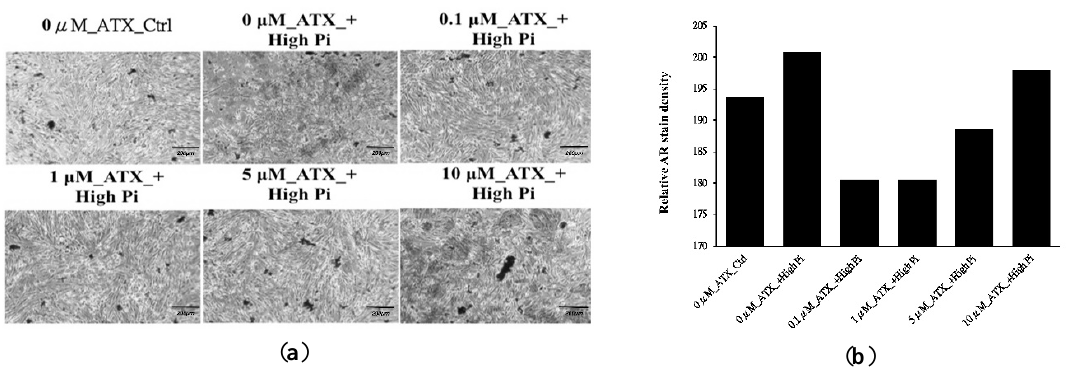
Figure 6. ( a ) Vascular smooth muscle cells were subjected to control medium (left upper) and high inorganic phosphate containing osteogenic medium without (middle upper) and with 0.1 (right upper), 1 (left lower), 5 (middle lower), and 10 (right lower) microM ATX. ATX, astaxanthin; Ctrl, control Pi, inorganic phosphate; ATX, astaxanthin; ( b ) the barplot of the relative alizarin red (AR) stain density.